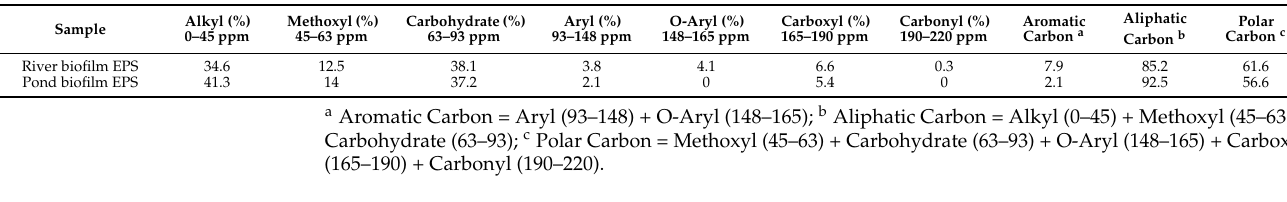
Table 2. Integration results of solid-state 13 C nuclear magnetic resonance of biofilm samples.